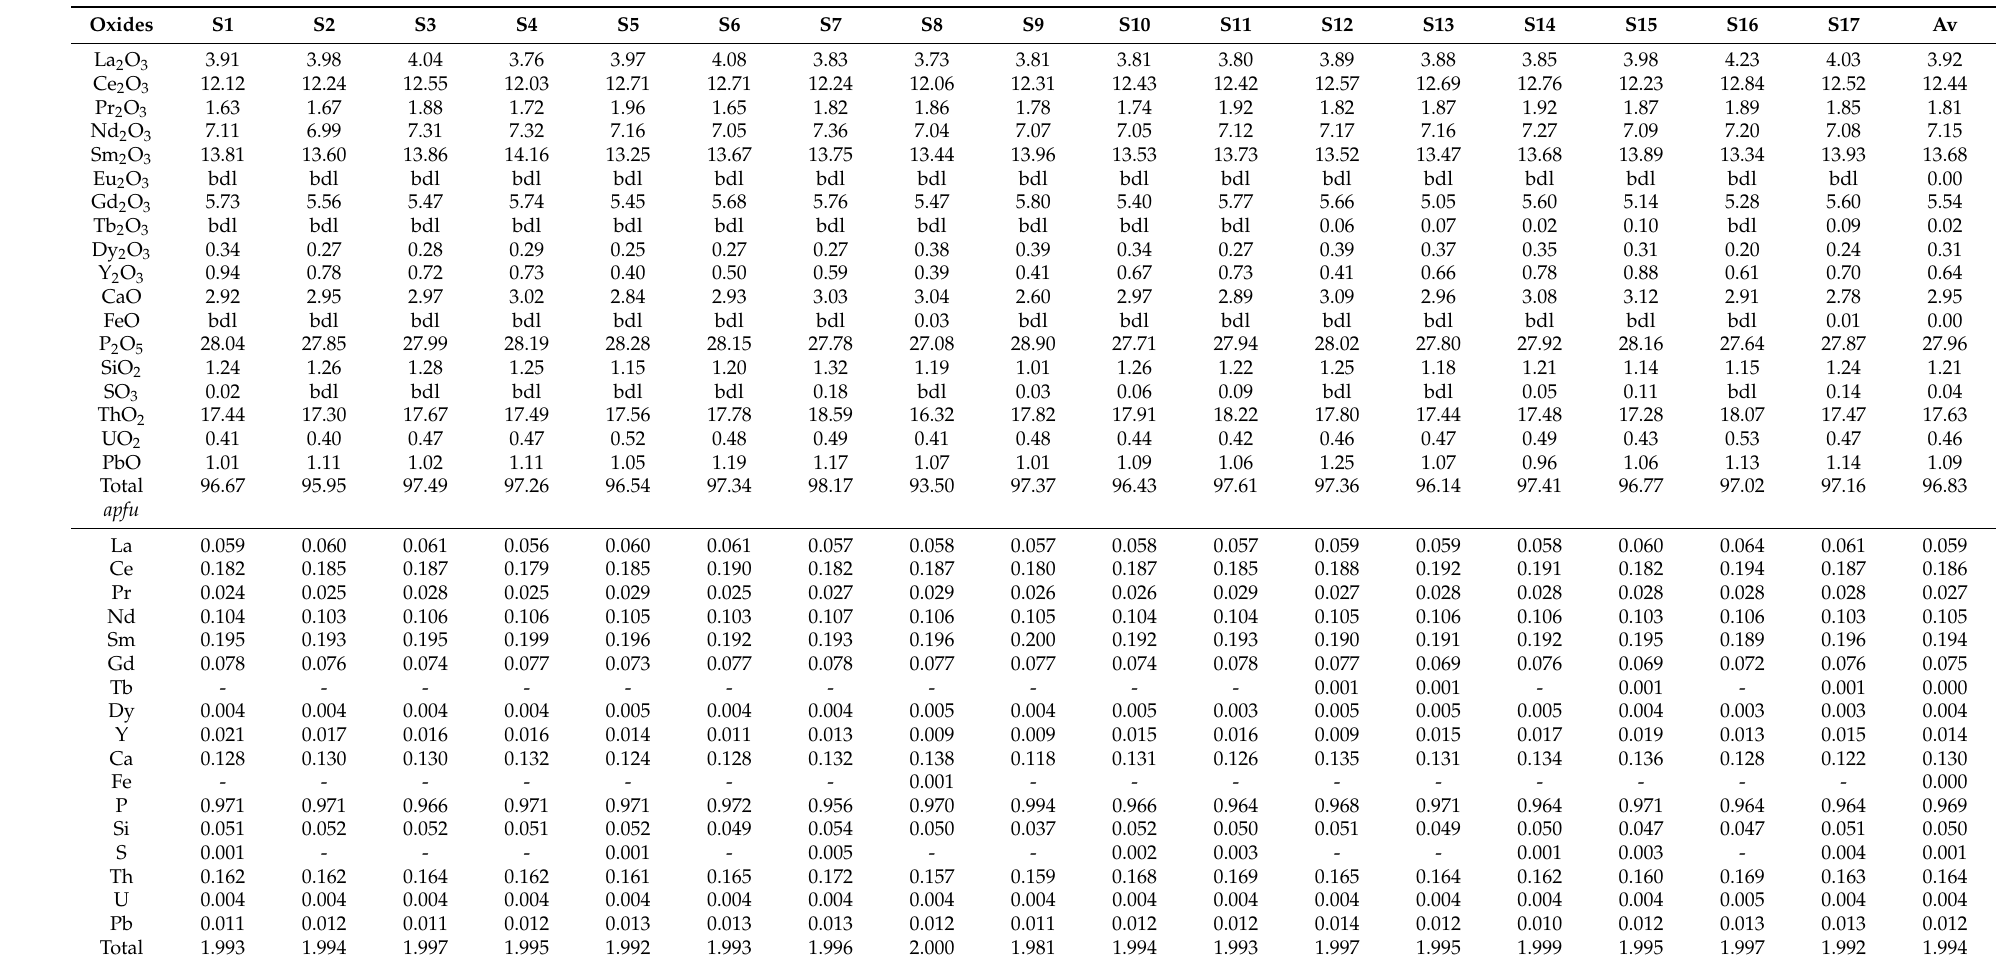
Table 3. Monazite-(Sm): EPMA data from 17 spots (S1 to S17) and their average (Av) for sample